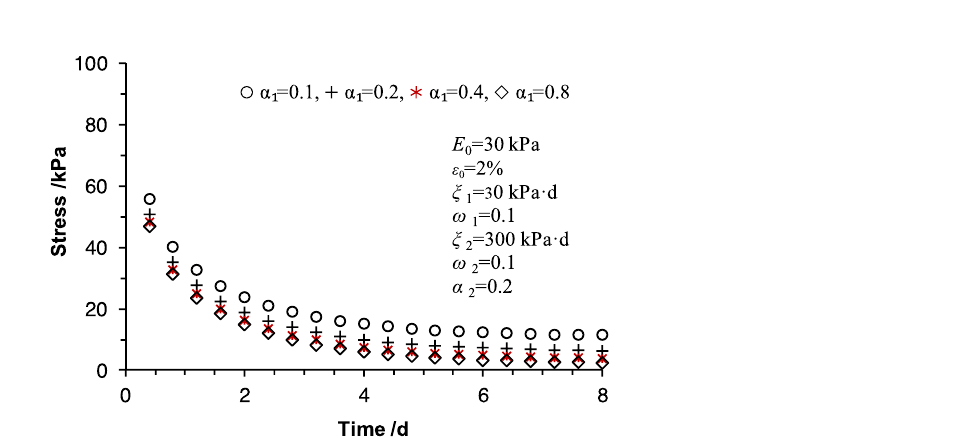
Figure 8. Comparisons of fitting curves by the proposed model and other models: ( a) case A, ( b) case B and ( c) case C.